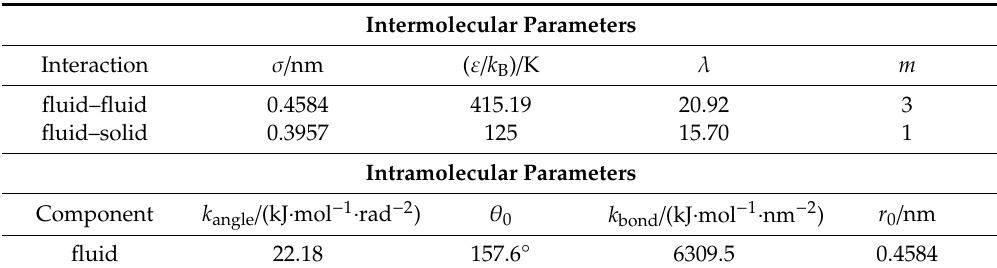
Table 2. SAFT CG force field parameters for fluid–fluid and solid–fluid interactions, k B is Boltzmann’s